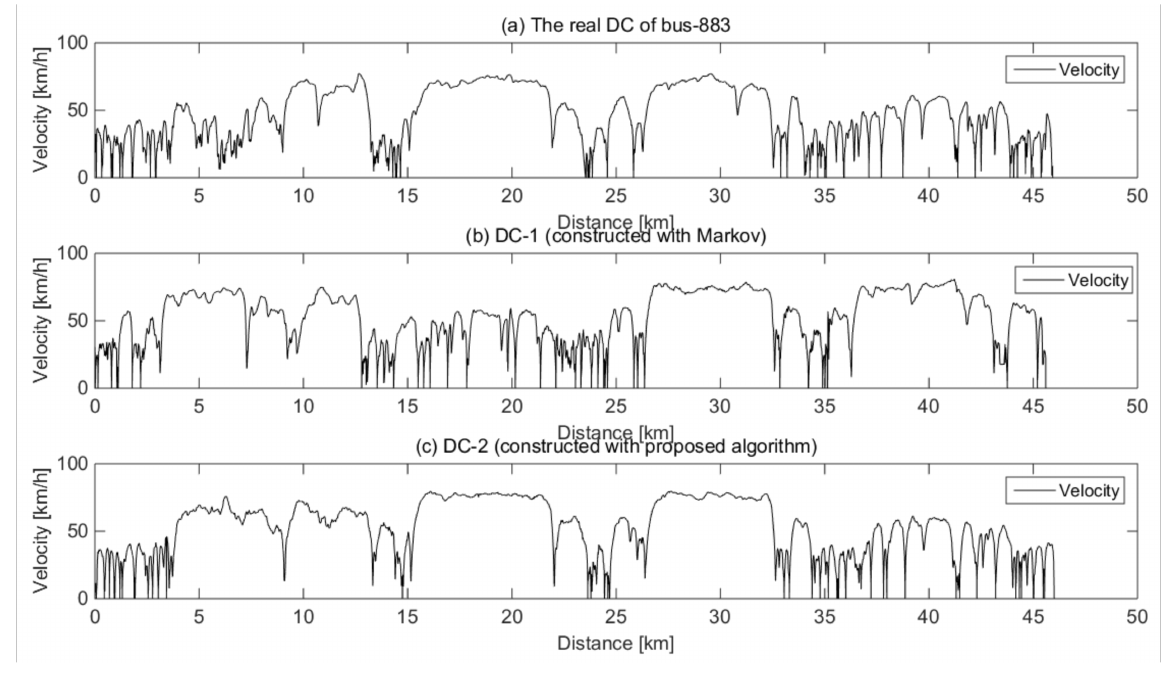
Figure 18. Comparison of three kinds of DC.